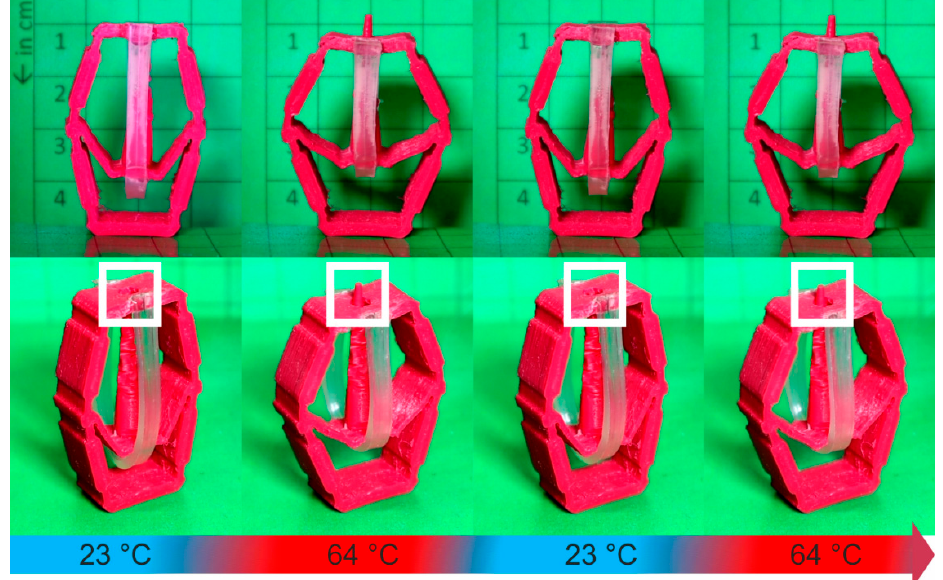
Figure 14. Thermoresponsiveness of a unit cell with a PEU actuator element. The system was cycled twice between 23 °C and 64 °C ( upper row: front view, centimeter paper was used as background paper; lower row: isometric view, the white box was drawn in to illustrate the shape change in the surface).